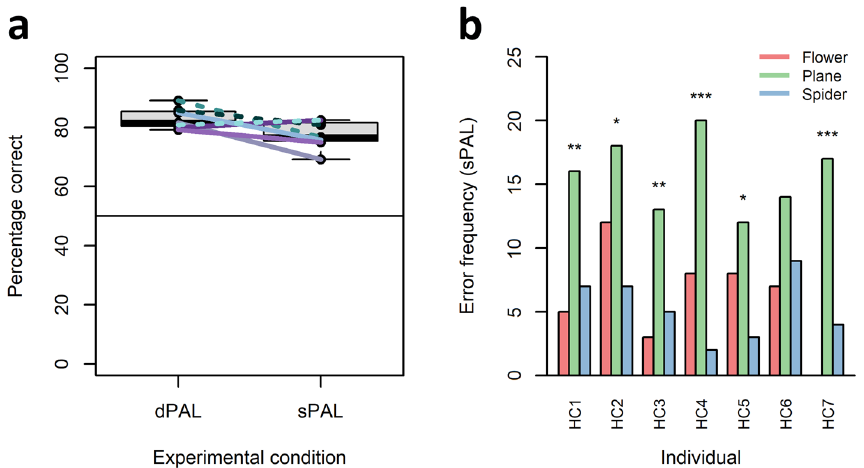
Figure 5. Performance and error patterns during sPAL challenge sessions. ( a ) Comparison of individual performances directly before (last 120 trials in dPAL) and during the sPAL challenge (120 trials). Dashed and solid horizontal lines represent individual trajectories. ( b ) Individual error frequencies during sPAL additionally separated by the identity of the S + (flower = SC 7 + SC 8 ; plane = SC 9 + SC 10 ; spider = SC 11 + SC 12 ). Significance code: * p < 0.05, ** p < 0.01, *** p < 0.001; one-tailed Binomial tests (for details see supporting Table